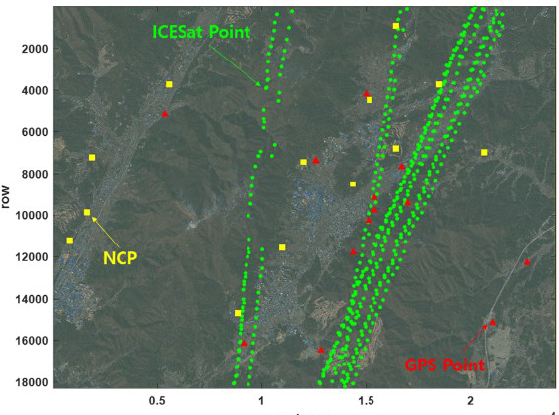
Figure 4. KOMPSAT-3 image for Yangsan; Distribution of ICESat points (green dots), NCPs (yellow rectangles), and GPS points (red triangles)